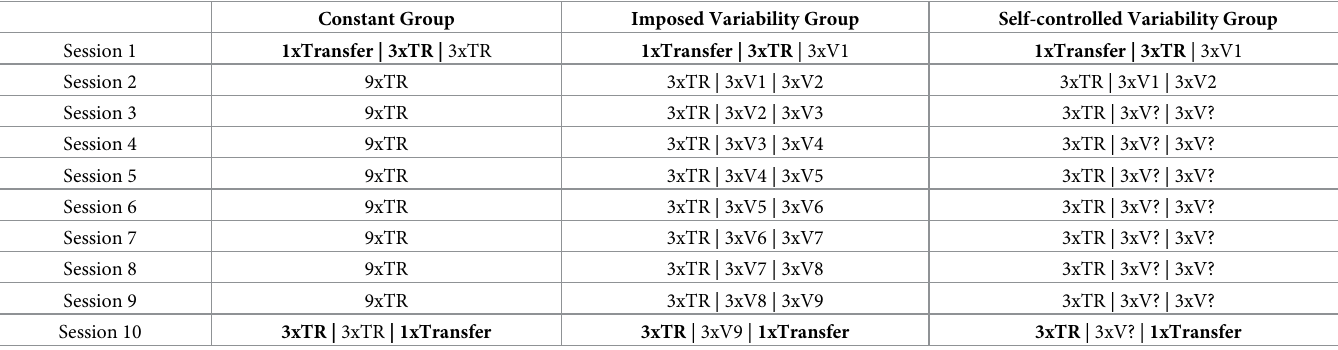
Instruction. Prior to each trial during the learning sessions, the participants were pro- vided with the following guidance: (i) to climb as fluently as possible, avoiding pauses and jerky movements of the body; (ii) to use all the handholds in an order from the bottom to the top of the wall; and (iii) to use all the handholds and footholds with a single limb contact at a time (participants couldn’t use a hold with both hands or feet at once). These instructions were repeated before each trial to ensure that participants were aware that the goal of each climb Table 1. Program of the learning sessions for the three